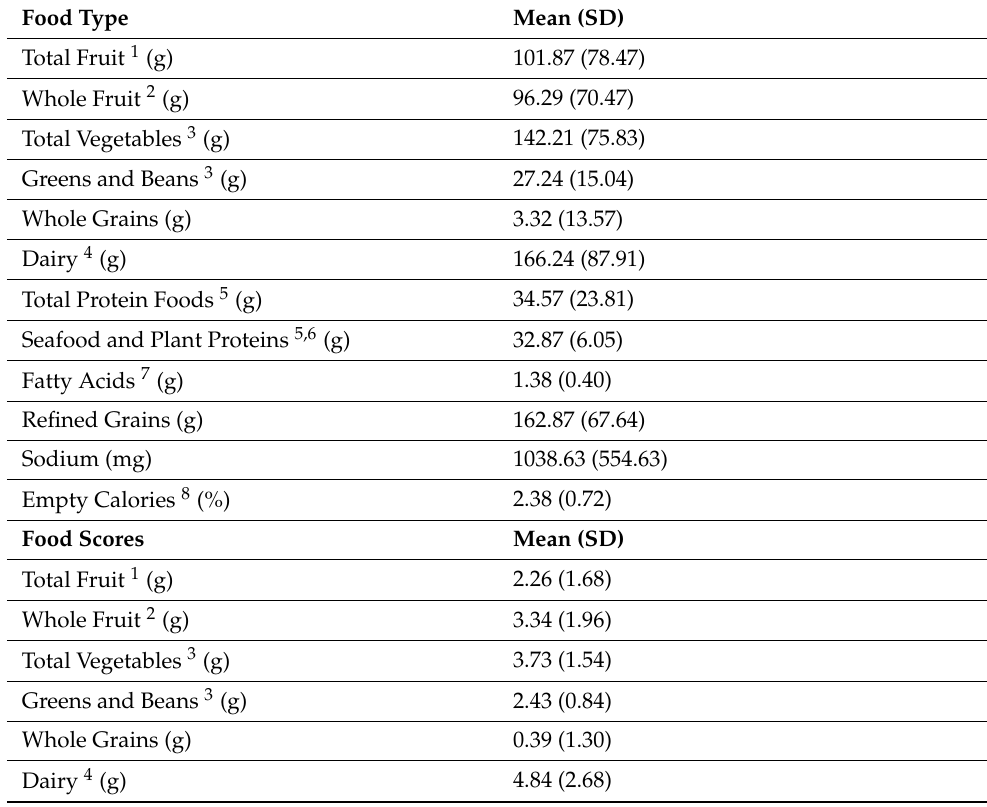
Table 3. Refugees’ food consumption, food group scores, and diet quality, as based on their HEI- 2010